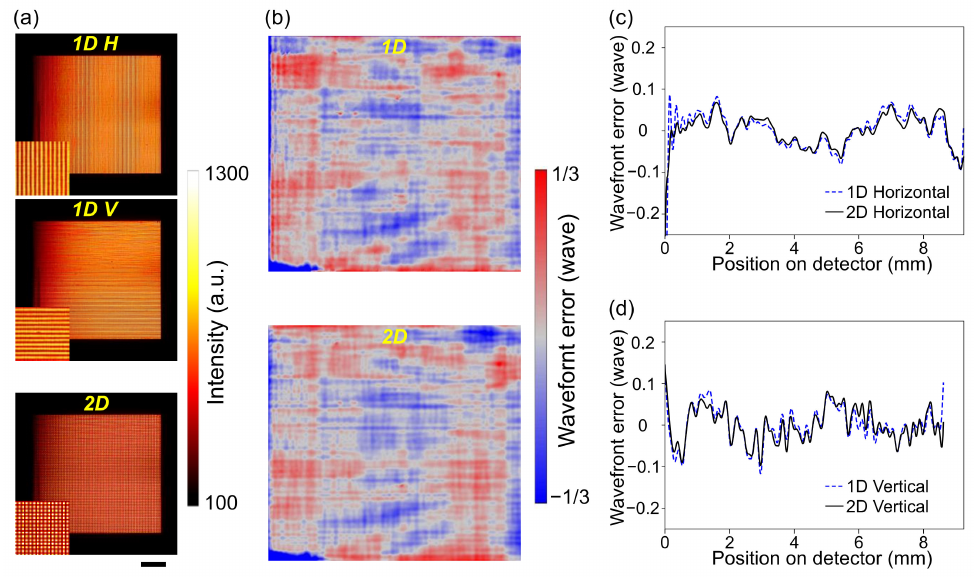
Figure 2. Comparison of the 1D and 2D gratings. ( a ) Obtained self-images with the 1D horizontal (top), 1D vertical (middle), and 2D checker-board (bottom) gratings. Insets show the zoom-in views of 2 × 2 mm 2 center areas. ( b ) Wavefront errors at the detector plane measured using the 1D (top) and the 2D (bottom) gratings. ( c , d ) Comparisons of the averaged profiles in the horizontal ( c ) and vertical ( d ) directions. All bars denote 2